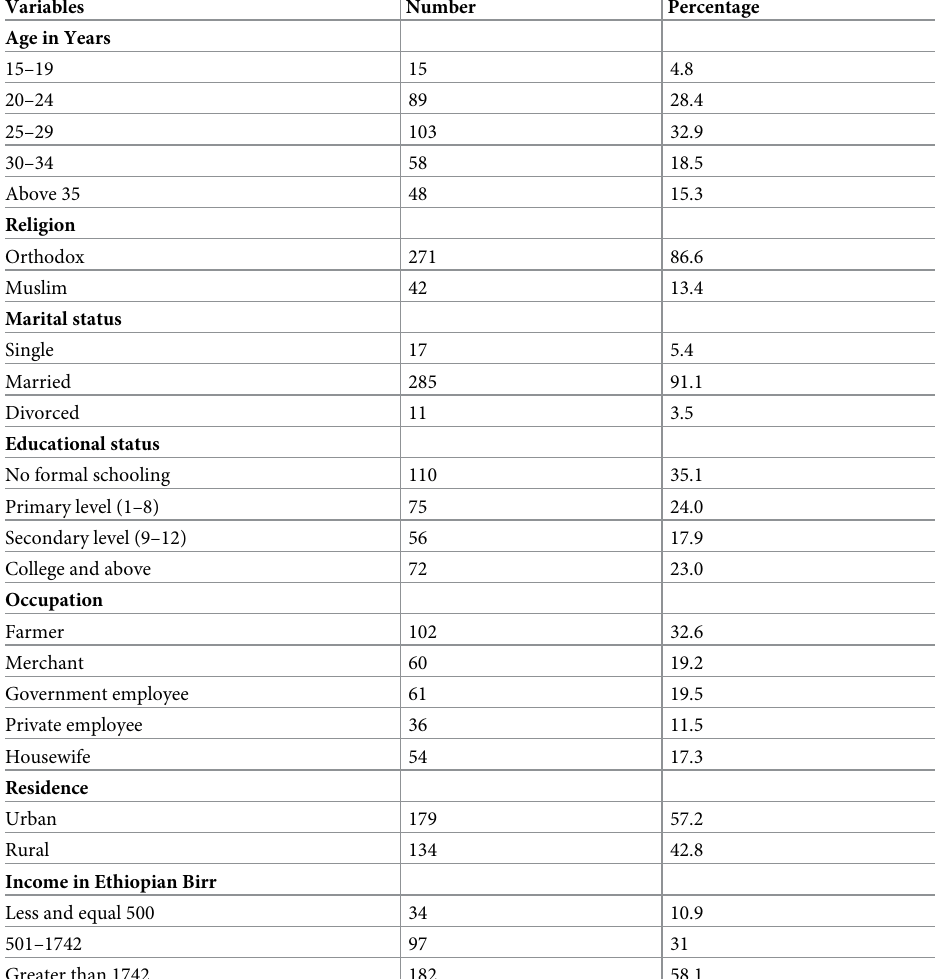
Table 1. Socio-demographic characteristics of the study participants on OVD at East Gojjam Zone Hospitals, Northwest Ethiopia, 2019(N = 313).